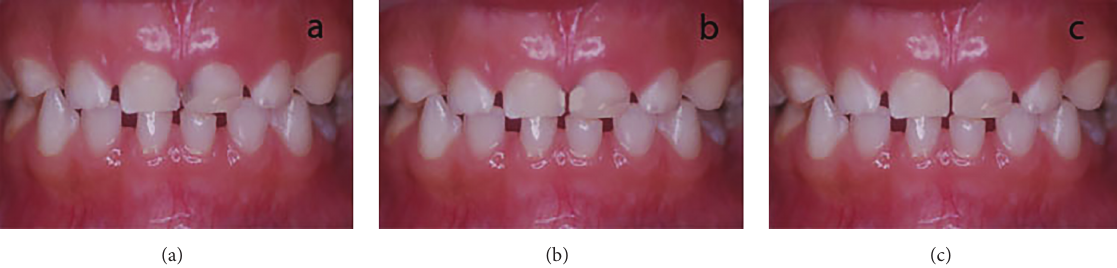
Figure 3: Type of treatment acceptable for anterior teeth with mild caries. (a) No treatment, (b) glass ionomer cement restoration, and (c) composite restoration.